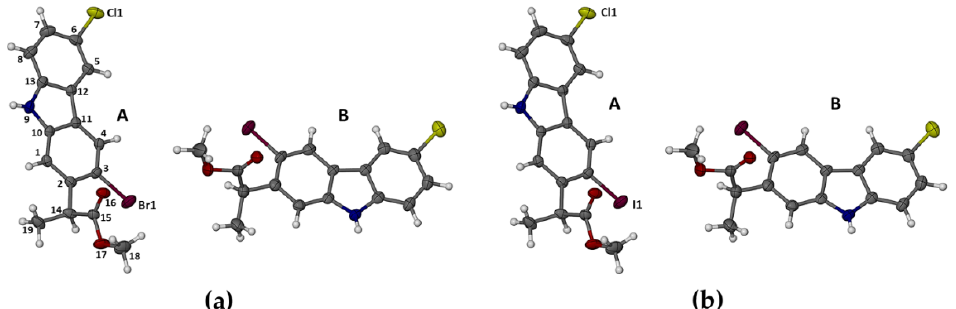
Figure 5. The molecular structures of 5 ( a ) and 8 ( b ), with non-hydrogen atoms drawn as thermal ellipsoids at the 50% probability level. The atomic numbering scheme shown in ( a ) was used for all four molecules.